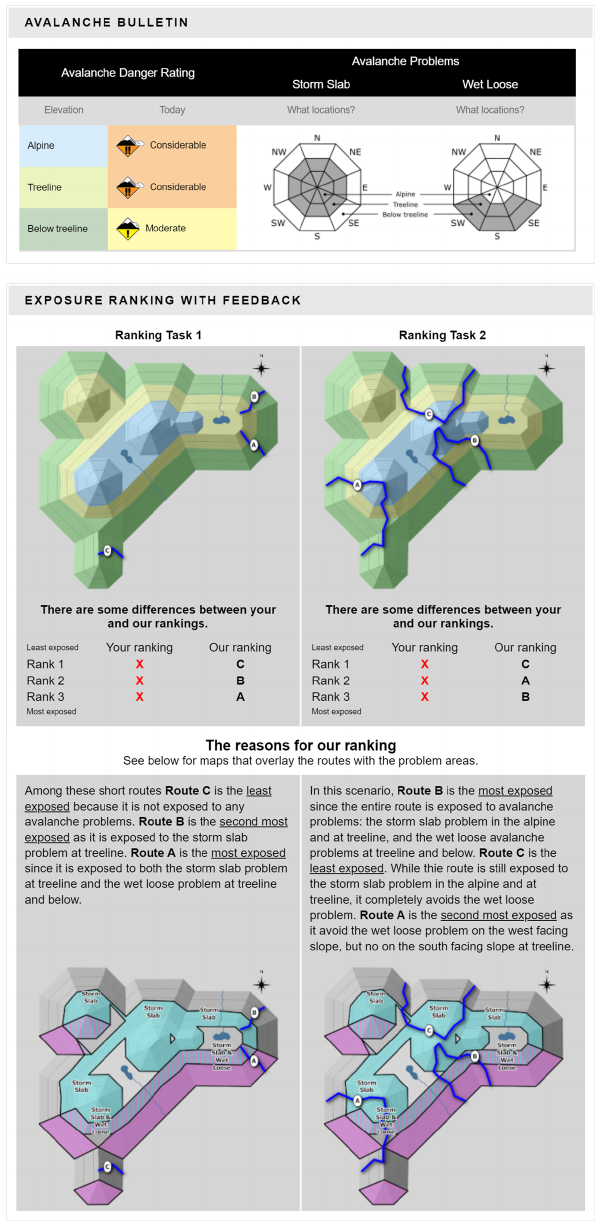
Figure A2. Screenshot of scenario 2 (ID 5) with avalanche bulletin information, route options, ranking solutions, and explanations.